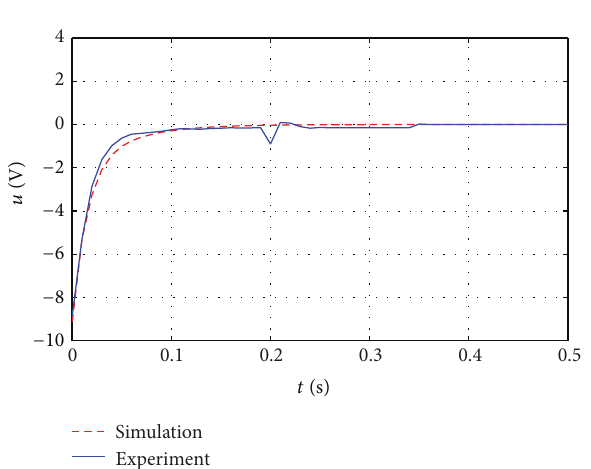
Figure 9: The control variable.